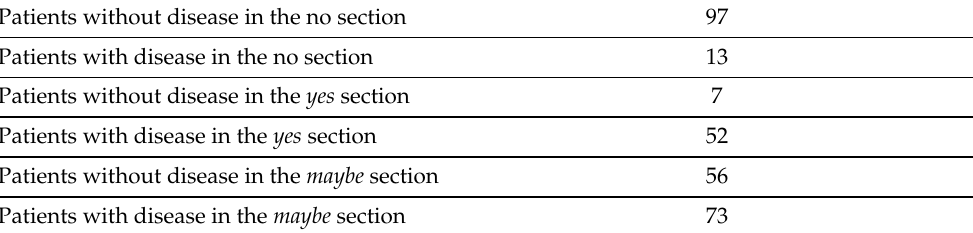
Table 4. Classification outcome; one can observe that the majority of points are correctly classified. Nevertheless, since the ground truth does not provide us with the actual number of patients belonging to the maybe class, one cannot use a well-known metric as accuracy, confusion matrix or mutual information [72,73]. A human-in-the-loop approach must be used to provide the labels for the samples in the maybe class. Patients without disease in the no section 97 Patients with disease in the no section 13 Patients without disease in the yes section 7 Patients with disease in the yes section 52 Patients without disease in the maybe